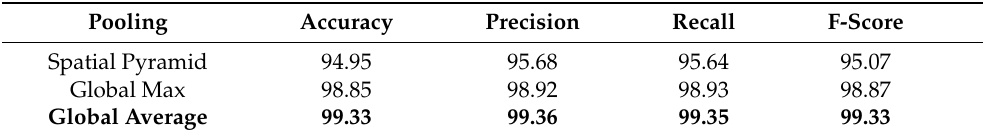
Table 6. Average recognition performance of KinectGaitNet with different pooling methods on the KGB dataset. The best performance is shown in